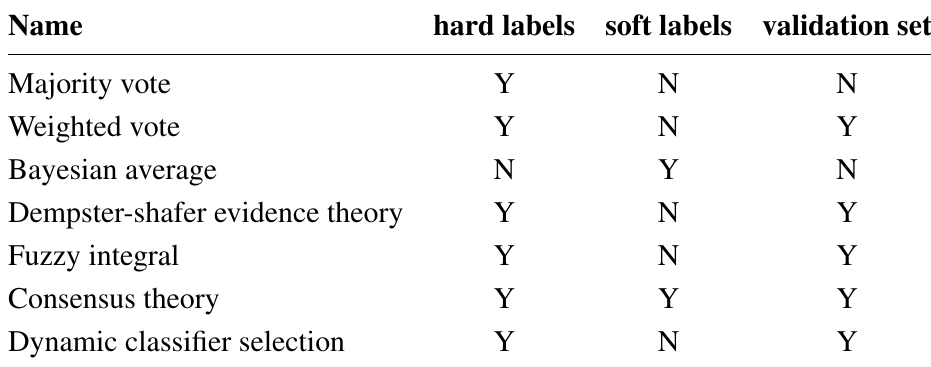
Table 1. Summary of the classifier ensemble approaches in parallel